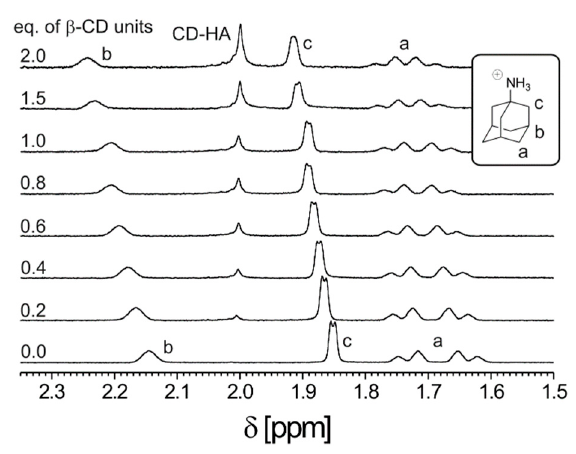
Figure 3. Stacking plot of portions of the 1 H-NMR spectra recorded within the titration of G1 with CD-HA (D 2 O, 30 °C).